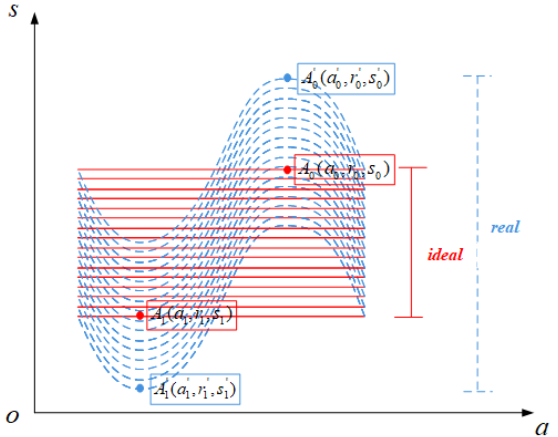
Figure 4. Trajectory projected into the azimuth–elevation geometric